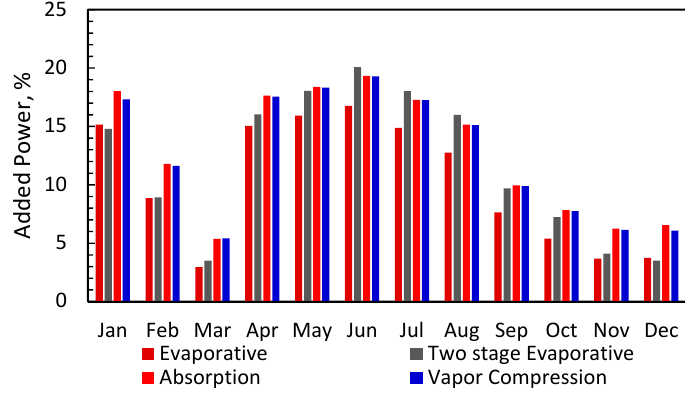
Figure 12. Added power